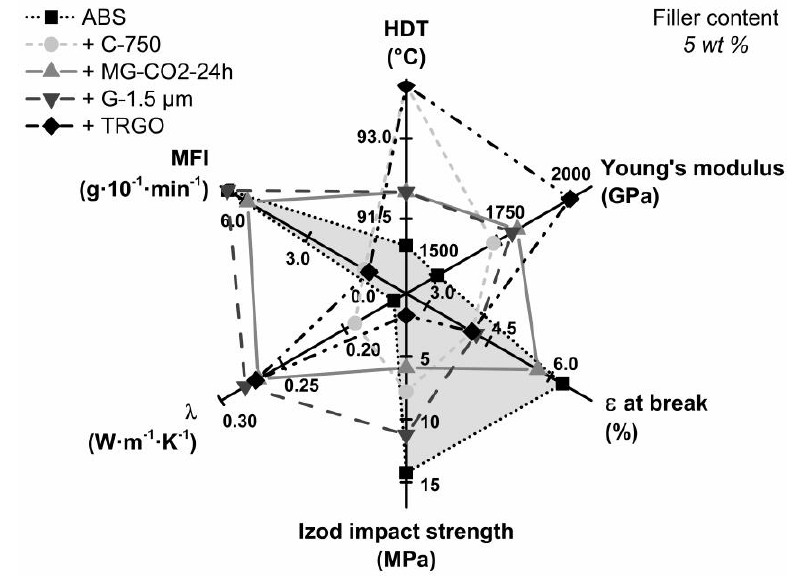
Figure 6. Property profiles of carbon/ABS nanocomposites containing 5 wt % carbon filler as a function of the filler type (gray surface are the properties of neat ABS).